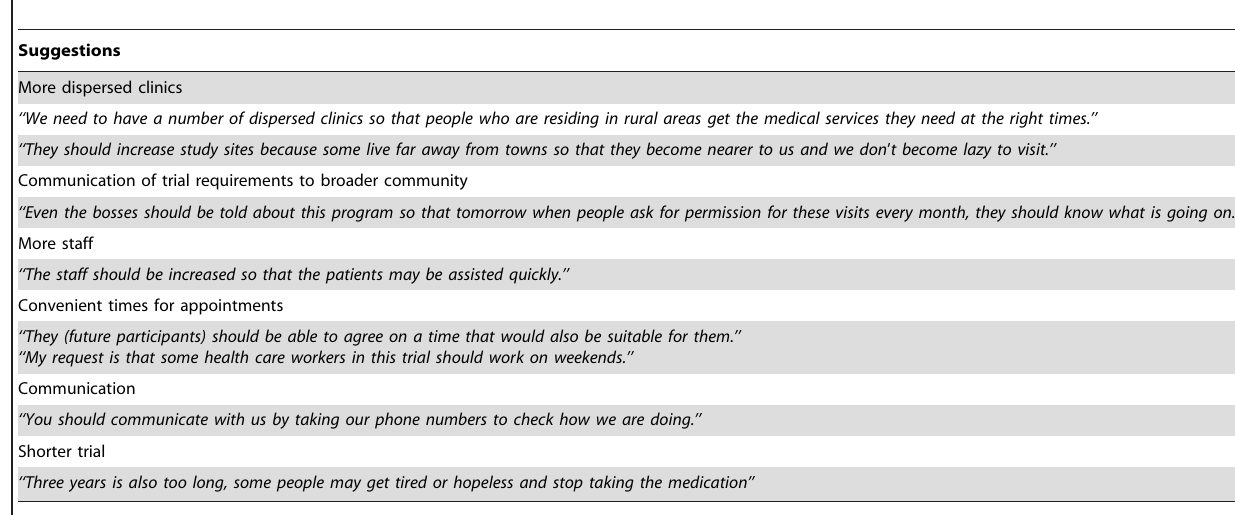
Table 3. Suggestions to improve retention from participants who were non-adherent or lost to follow-up in the Botswana Isoniazid Preventive Therapy Trial,